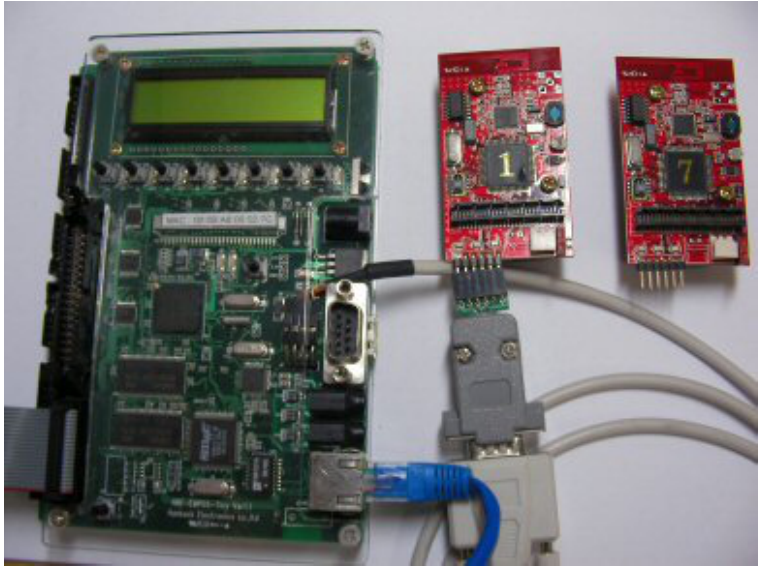
Figure 3. A Linux machine and sensors for the prototype implementation of